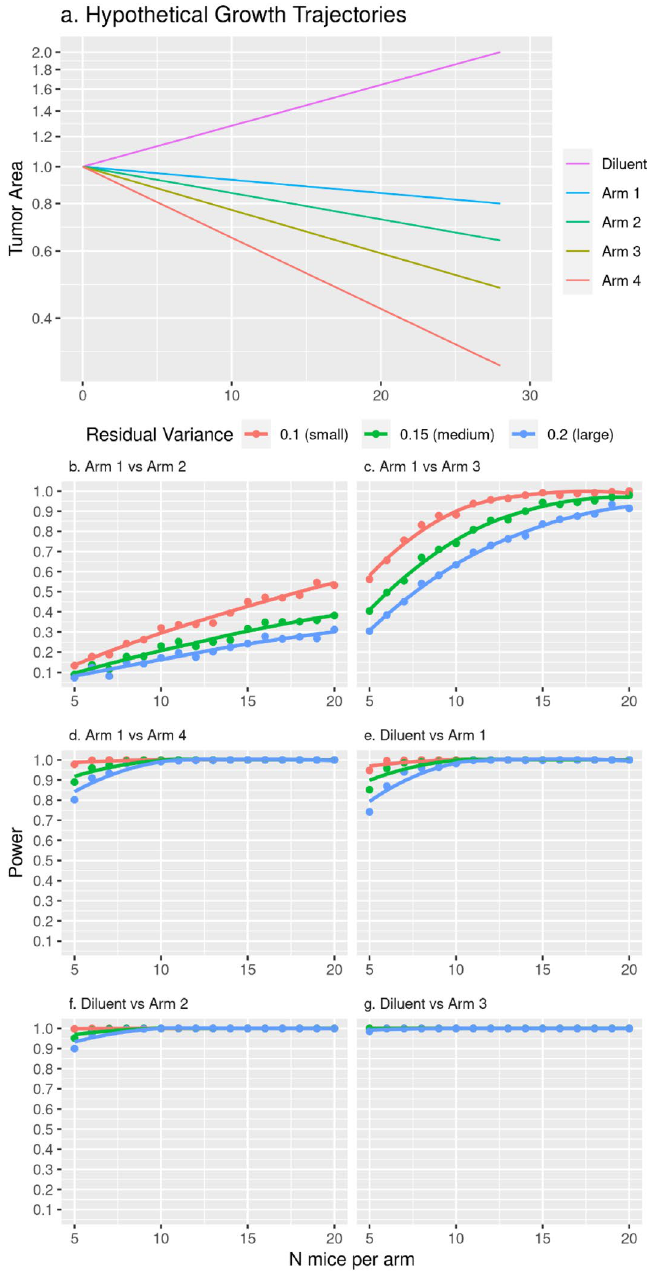
Figure 4. Statistical power as a function of residual variance and sample size. Straight growth trajectories were simulated with sp(pow) covariance structure at small (0.1), medium (0.2) and large (0.3) residual variance values representing approximate Q25, Q50 and Q75 percentiles of the NCT02312245 clinical trial PDX model ln ( A t ) residual variance distribution, sp(pow) structure with parameter 0.98, and two-sided type I error rate of α = 0.05. Hypothetical growth trajectories are shown in panel ( a ) for a diluent arm with tumor growing to 2cm 2 day 28 area and active arms shrinking to 0.8cm 2 , 0.64cm 2 , 0.48cm 2 , and 0.3cm 2 day 28 area. Tumor area is plotted on the natural log scale and labeled on the raw cm 2 scale. We calculated statistical power for the specified two degree of freedom coincident curve hypothesis tests in panels ( b – g ) as the proportion of times out of 500 simulated datasets that the p-value was less than 0.05. Panels ( b – d ) represent hypothetical primary hypothesis tests versus arm 1, and panels ( e – f ) represent hypothetical secondary hypothesis tests versus diluent. Specifically, ( b ) arm 1 vs. arm 2 (day 28 area represents a 20% decrease from arm 1), ( c ) arm 1 vs. arm 3 (day 28 area represents a 40% decrease from arm 1), ( d ) arm 1 vs. arm 4 (day 28 area represents a 63% decrease from arm 1), ( e ) diluent vs. arm 1, ( f ) diluent vs. arm 2, ( g ) diluent vs. arm 3. Diluent vs. arm 4 has the same power as diluent vs. arm 3 so is not